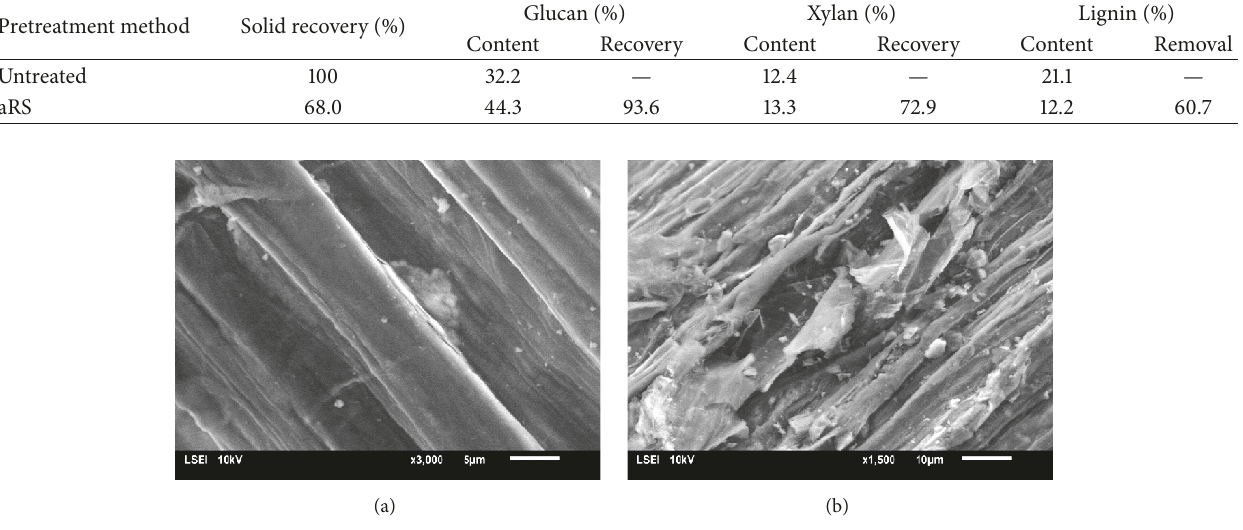
Figure 2: SEM micrographs: (a) untreated RS and (b)